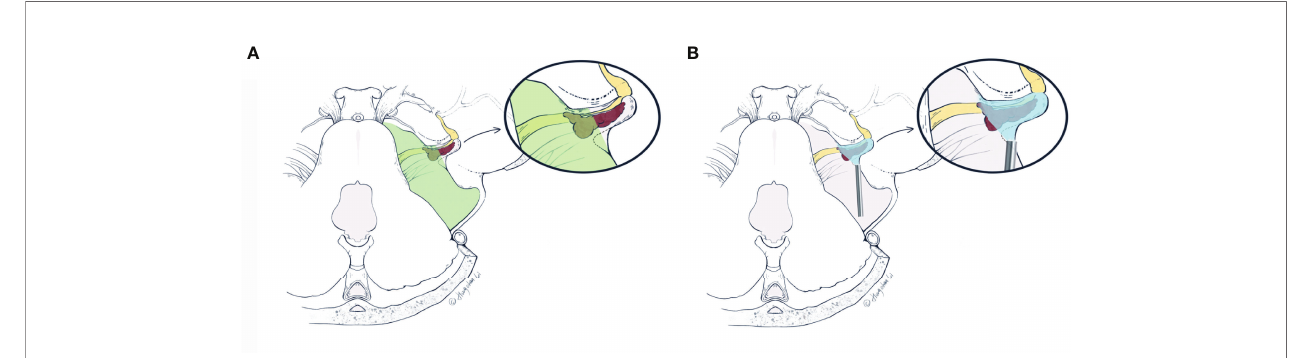
FIGURE 6 | The artist ’ s (Hongchan Li) illustrative comparisons of differences in visualizations of the retrosigmoid approach under the microscope (A) and neuroendoscope (B) , respectively. The vestibular schwannoma (red) is fi rst debulked at the porus acusticus, and the posterior IAC is drilled based on pre-operative planning. Drilling range of the posterior wall of IAC is delineated by dashed lines (in A , B ) as a triangle area from an axial view. (A) The microscopic view (green area) is limited by the bony anatomy of the retrosigmoid approach, which prevents further resection of the intracanalicular portion. These tumor remnants within the IAC tend to recur and erode adjacent structures. (B) The endoscopic viewing area (blue area) includes both extra- and intracanalicular portions. With a 0- or 30-degree endoscope, the area dif fi cult for microscopic view within IAC can be more readily visualized, which facilitates gross total resection of the tumor. IAC, internal acoustic canal (Used with permission from Hongchan